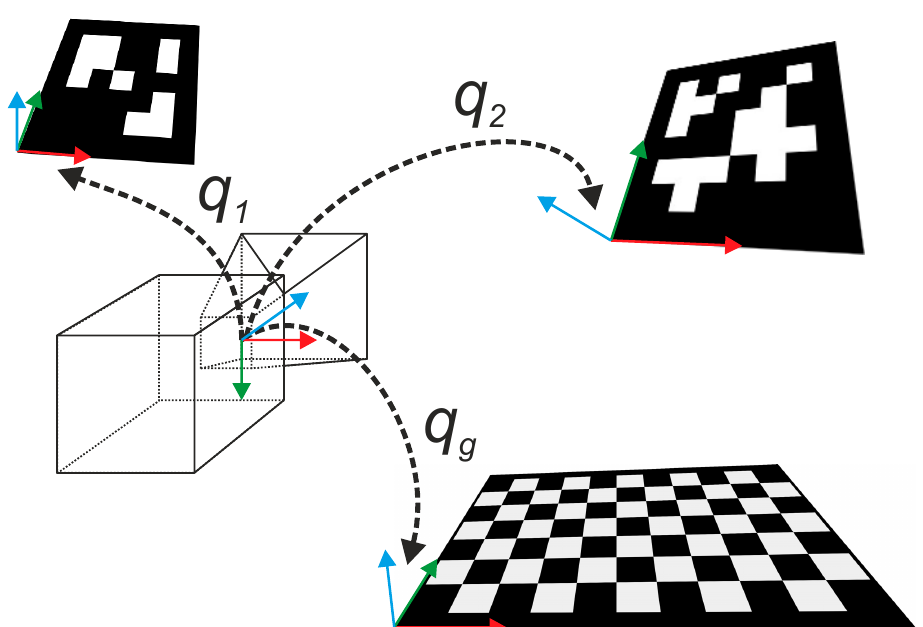
Figure 7. Using the ArUco module and the checkerboard calibration tool of OpenCV we get rotation matrices and translation vectors of each marker from the camera reference frame. Here we depict the quaternions q 1 and q 2 representing the rotation of two ArUco markers and the quaternion q g from the checkerboard representing the ground floor.